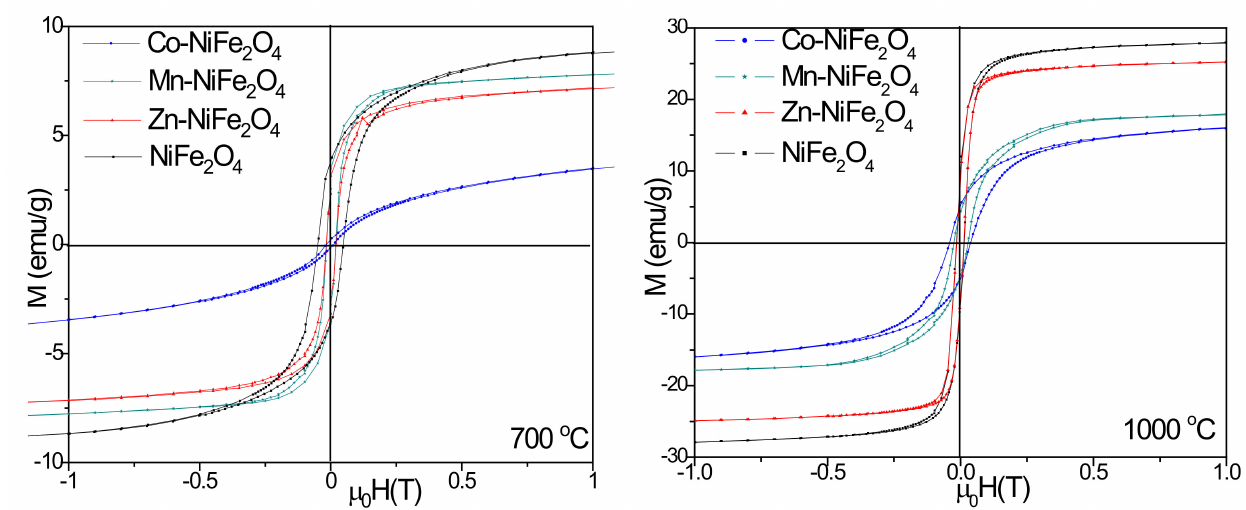
Figure 7. Magnetic hysteresis loops of virgin and doped NiFe 2 O 4 (Zn-NiFe 2 O 4 , Mn-NiFe 2 O 4 , Co- NiFe 2 O 4 ) NCs annealed at 700 and 1000 ◦